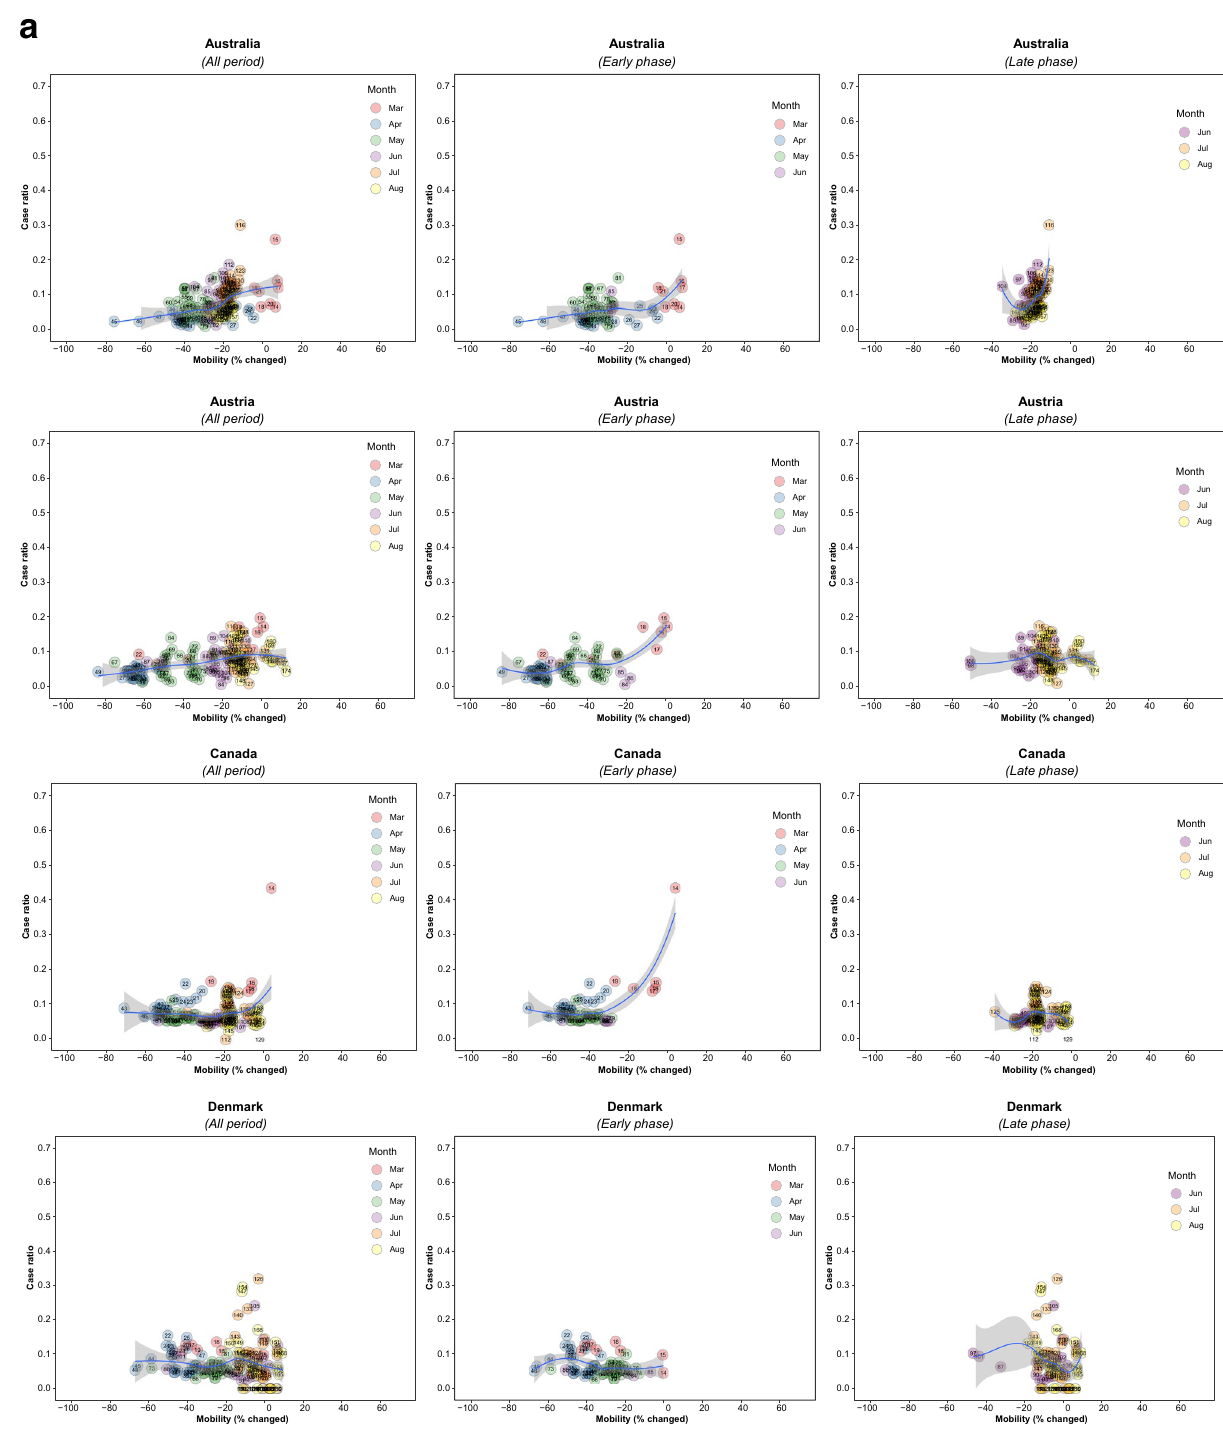
Figure 2. Association between new daily COVID-19 case ratio and commuting mobility changes in each of 36 countries by pandemic phase. ( A ) Western Europe, North America, and Oceania countries. ( B ) Asia, Eastern Europe, Latin America, and Caribbean countries. Footnote 1. The mobility change measurement period was from the day of the 100th case in each country through August 31, 2020. Footnote 2. Pandemic phase was defined for each country by the median of the date when the 100th case was detected to the end of the study period: early phase for the period before the median date and late phase for the period after the median